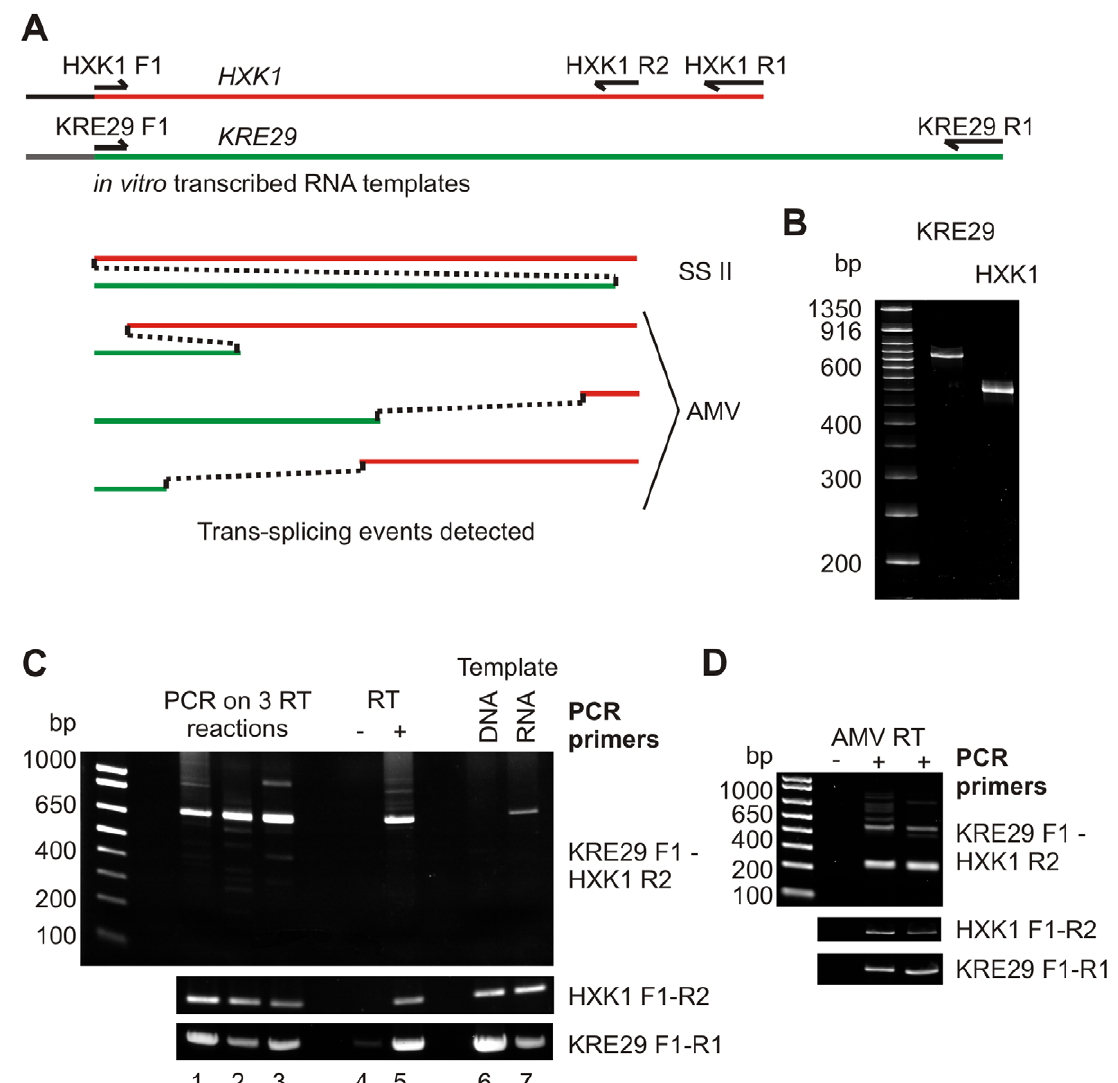
Figure 2. An invitro system for the analysis of apparent trans-splicing. A: HXK1 and KRE29 substrate RNAs showing primer locations. Template switching events produced by Superscript II and AMV are indicated. B: Purified substrate RNAs. C: RT-PCR using primers complementary to each RNA on three independent RT reactions (lanes 1–3), and a no RT control (Lanes 4–5). The template for the DNA control (lanes 6–7) was HeLa cDNA with restriction fragments encompassing the entire sequence of the substrate RNAs. Upper panel 35 cycles, other panels 25 cycles. D: PCR reactions performed as in C on cDNA produced with AMV reverse transcriptase. Upper panel 35 cycles; lower panels 25 cycles.